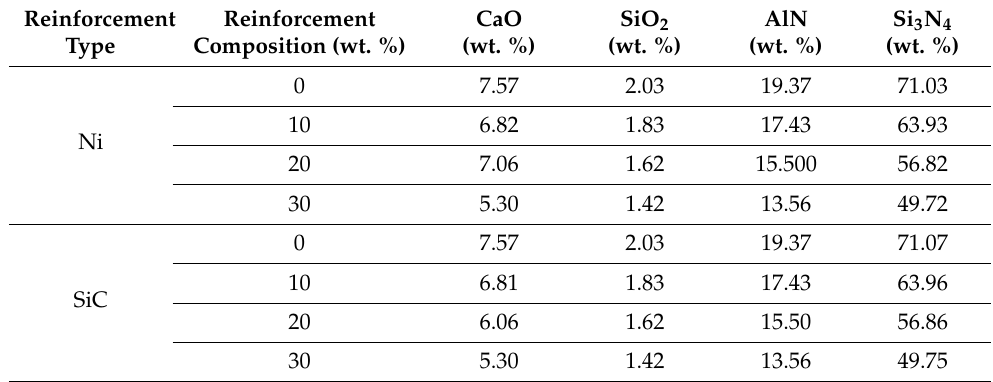
Table 2. Compositions (in wt.%) of SiC- and Ni-reinforced α -SiAlON composites with powder precursors.